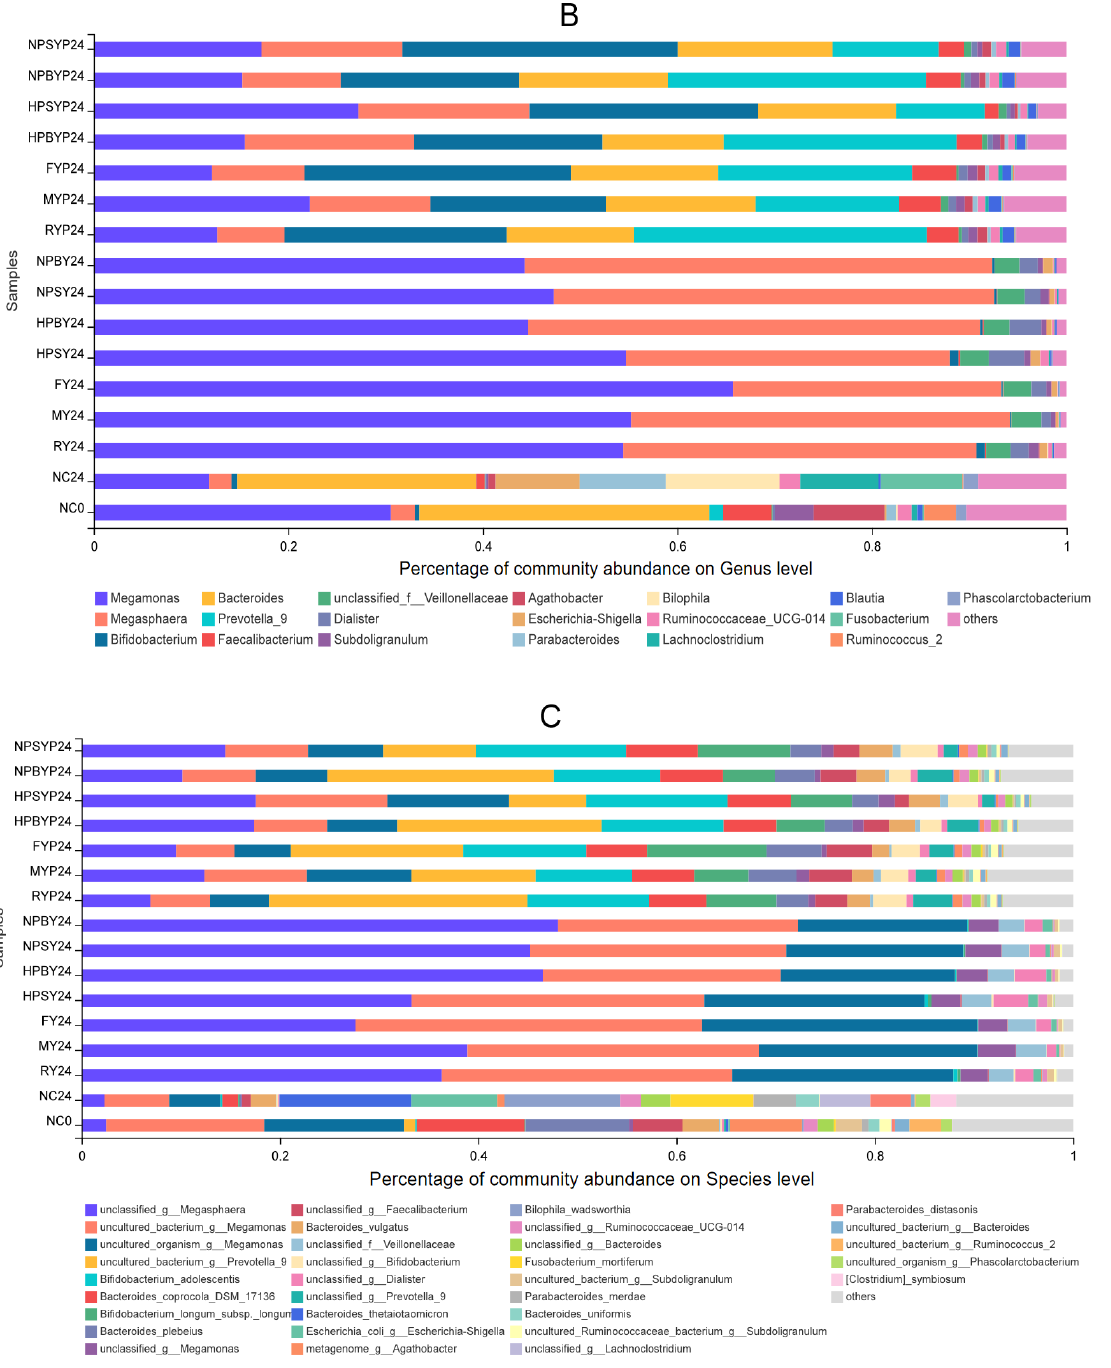
Figure 1. Relative bacterial abundance (at the phylum/genus/species level) after in vitro fermenta- tion of the cooked yam digesta and polysaccharides. Note: A = at phylum level, B = at genus level, C = at species level. Note: 0 h fermentation broth, 24 h fermentation broth. NC = blank, NPSY = Normal-pressure steamed yam, NPBY = Normal-pressure boiled yam, HPSY = High-pressure steamed yam, HPBY = High-pressure boiled yam, MY = Microwaved yam, FY = Stir-fried yam. RY = Raw yam. NPSYP = Normal-pressure steamed yam polysaccharide, NPBYP = Normal-pressure boiled yam polysaccharide, HPSYP = High-pressure steamed yam polysaccharide, HPBYP = High- pressure boiled yam polysaccharide, MYP = Microwaved yam polysaccharide, FYP = Stir-fried yam polysaccharide, RYP = Raw yam polysaccharide.